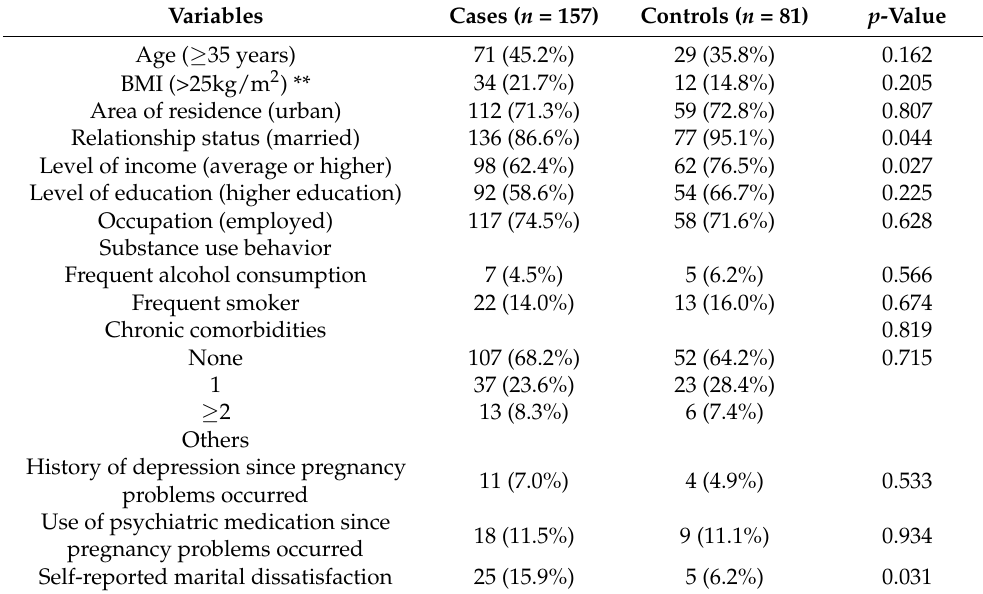
Table 1. Comparison of background characteristics between women with thrombophilia and recurrent pregnancy loss (cases), women with thrombophilia and recurrent pregnancy loss who achieved a normal pregnancy, and preterm or full-term birth